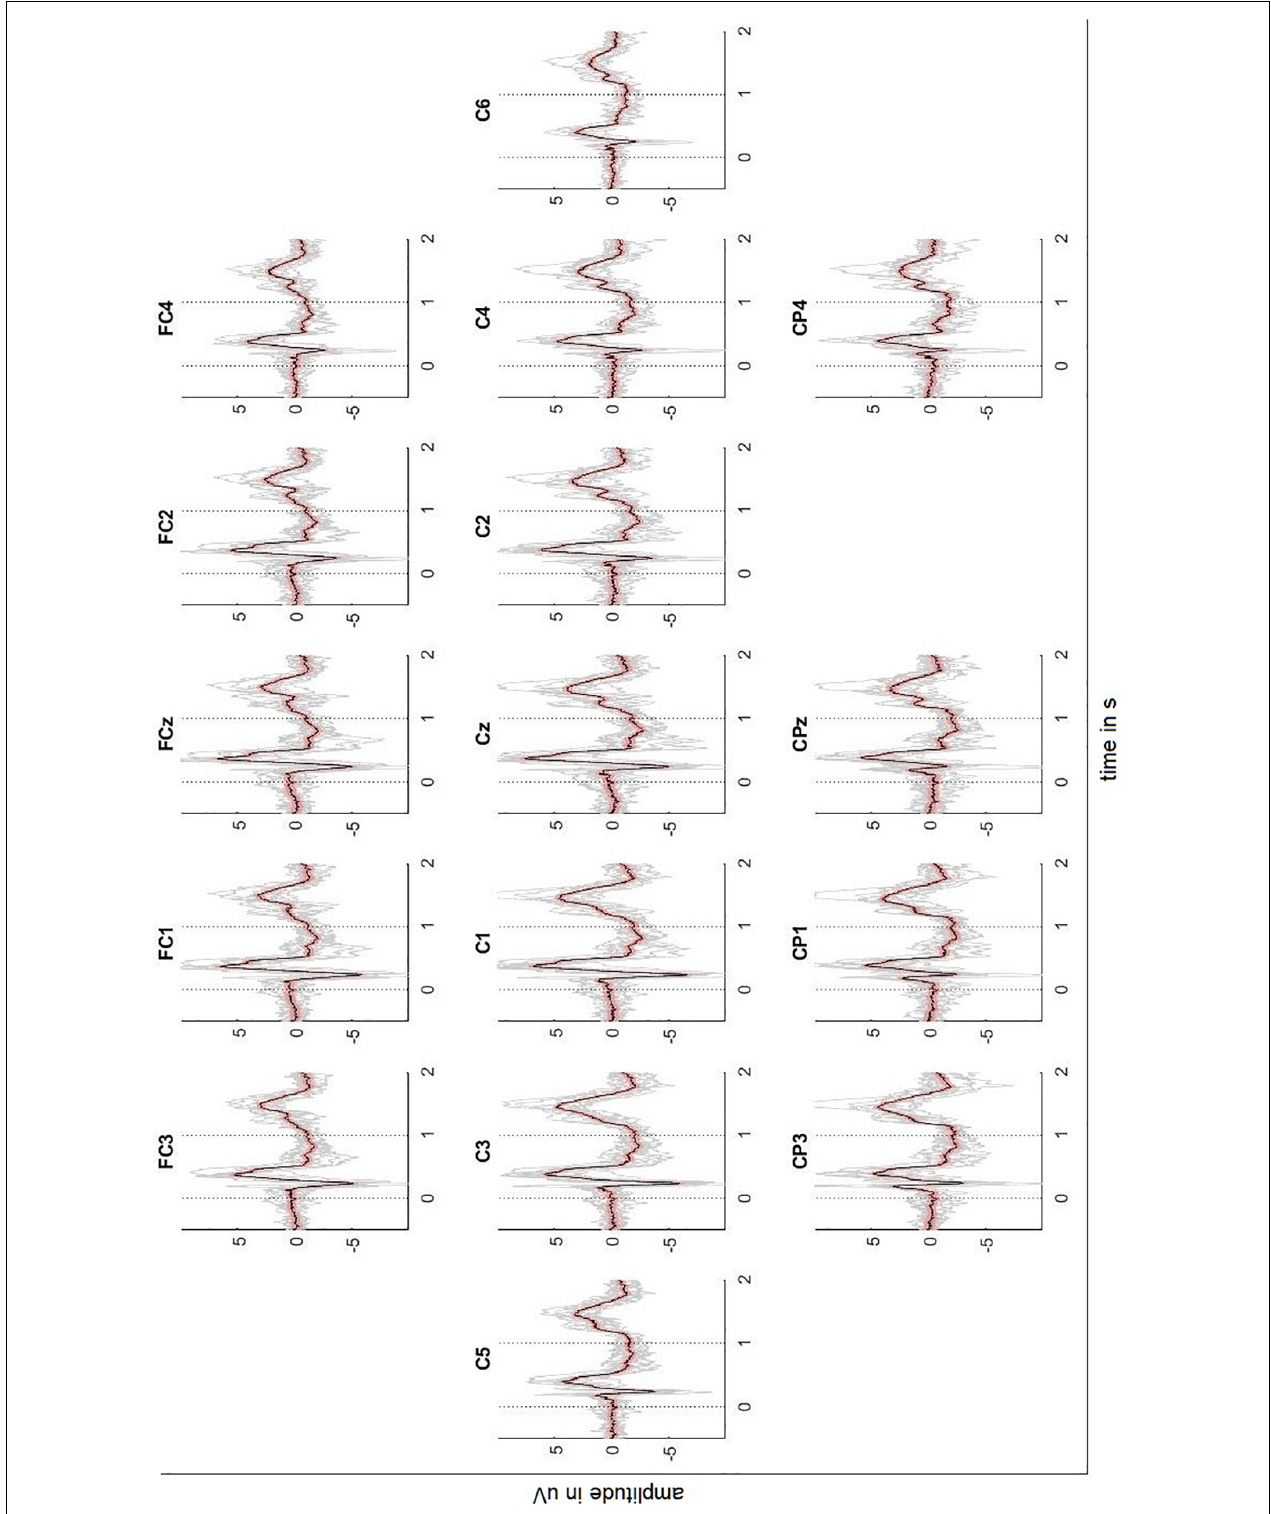
FIGURE 2 | Averaged EEG signals recorded above the sensorimotor cortex with ± 2 standard error (red) and individual results of the ten participants (gray). Dotted lines indicate the stimulus onset and offset.